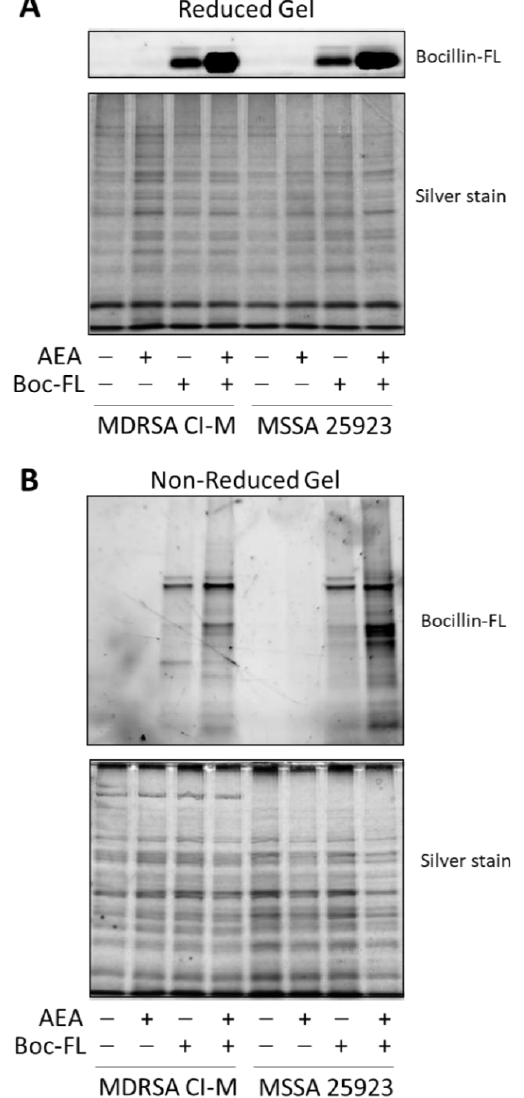
Figure 3. AEA increases the intracellular concentration of Bocillin-FL with enhanced binding of Bocillin-FL to membrane proteins. Protein extracts were prepared from MDRSA CI-M and MSSA 25923 that were incubated in the absence or presence of 50 µg/mL AEA for 1 h followed by a 1 h incubation with 10 µg/mL Bocillin-FL. ( A ). The soluble fraction was run on a 10% SDS-PAGE gel under reducing conditions. Upper panel shows the green fluorescence of Bocillin-FL and the lower panel the gel after silver staining. The free Bocillin-FL ran at the front of the gel. ( B ). The membrane fraction was run on a 10% SDS-PAGE gel under non-reducing conditions. Upper panel shows the green fluorescence of Bocillin-FL bound to membrane proteins and the lower panel the gel after silver staining.